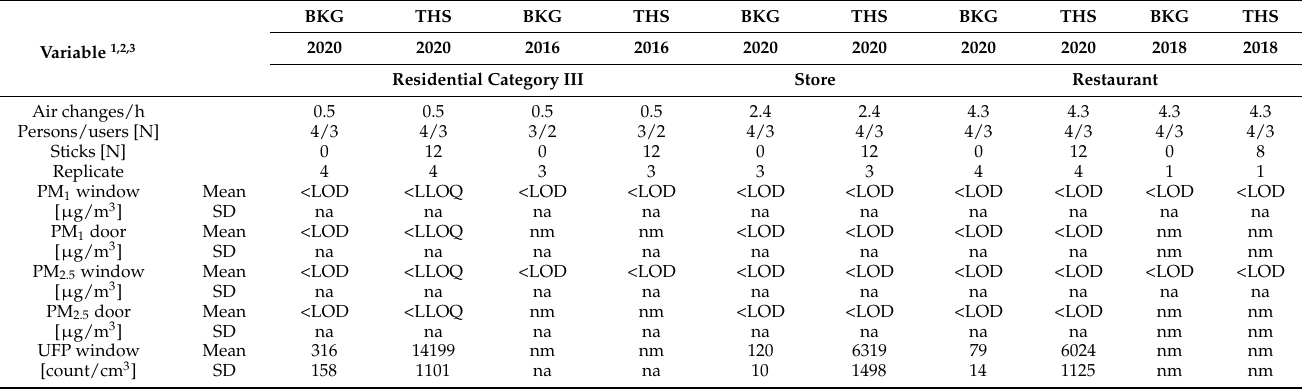
Figure 6. Comparison of NO x traces (ppb) during the background (BKG), break, and THS 2.2 sessions (THS) under the simulated Residential category III environment (0.5 h −1 ). Table 2. Summary of mean concentrations of airborne constituents measured online in the background and THS 2.2 environmental aerosol under simulated Residential category III (0.5 air changes/h), Store (2.4 air changes/h), and Restaurant environmental conditions (4.3 air